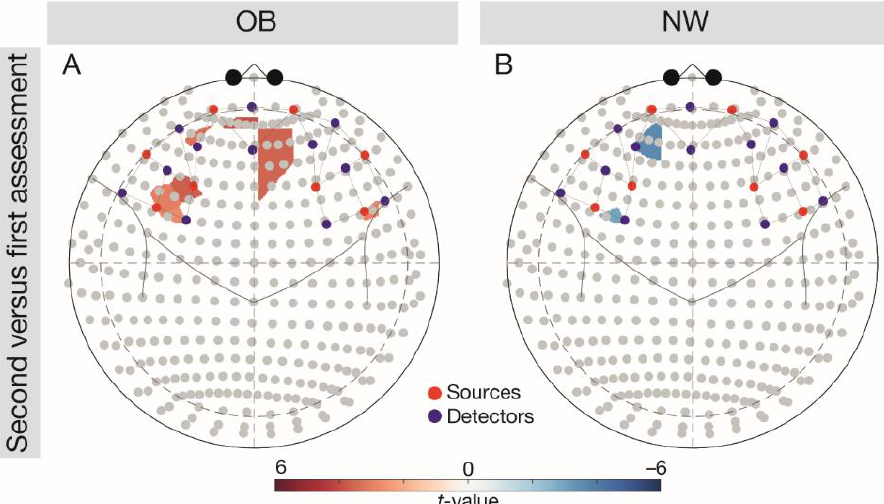
Figure 3. Follow-up comparisons (FDR-corrected t -tests) on the group-wise variability of brain responses (second-first assessment) depicted in the 10–20 system. Results were analysed across tasks. ( A ) Depicting the difference for the OB group, ( B ) difference for the NW group. Red colouring indicates higher brain responses at the second versus first, blue colouring indicates higher brain responses at the first versus second assessment. Red dots depict sources, blue dots depict detectors. NW, normal weight; OB, obesity.